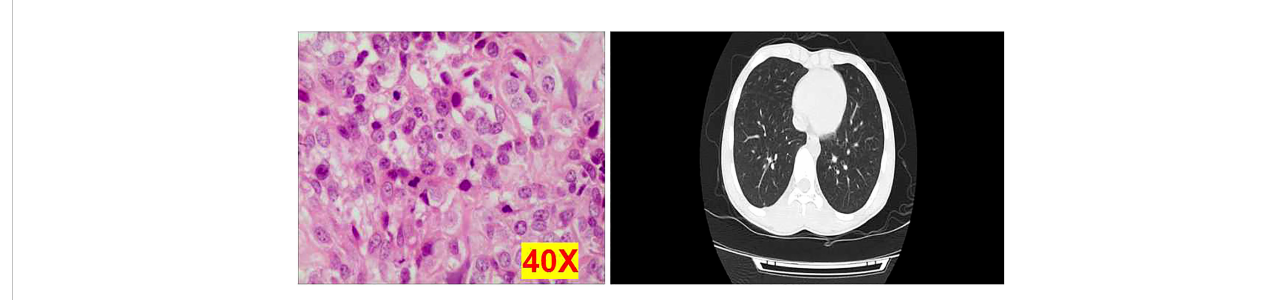
FIGURE 1 Representative images of osteosarcoma tissues using hematoxylin and eosin staining and computed tomography examination. Each experiment was repeated for three times, and each group had four